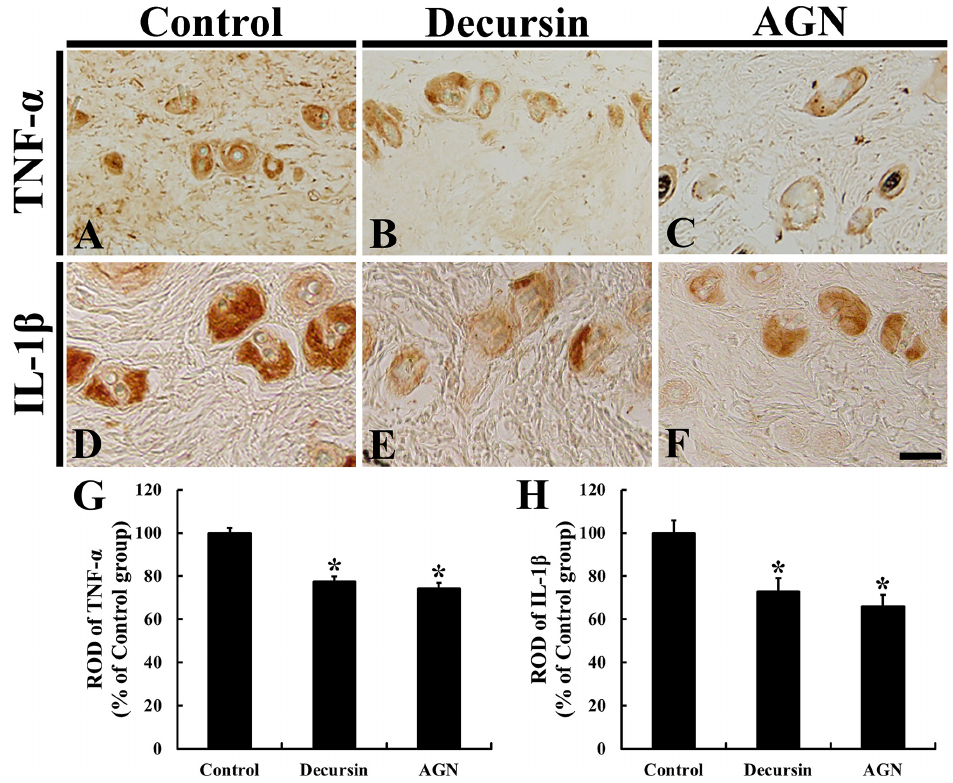
Figure 5. Immunohistochemistry for TNF-α ( A – C ) and IL-1β ( D – F ) in the dorsal skin of the control ( A ) and ( D ), decursin ( B ) and ( E ) and AGN ( C ) and ( F ) groups at 17 days. Regarding the decursin and AGN groups, both TNF-α and IL-1β immunoreactivities are significantly weakened compared to those in the control group. Scale bar = 40 μm. ( G ) and ( H ): ROD of TNF-α ( G ) and IL-1β ( H ) ( n = 10 in each group; * p < 0.05 versus control group). The bars indicate the means ± SEM.